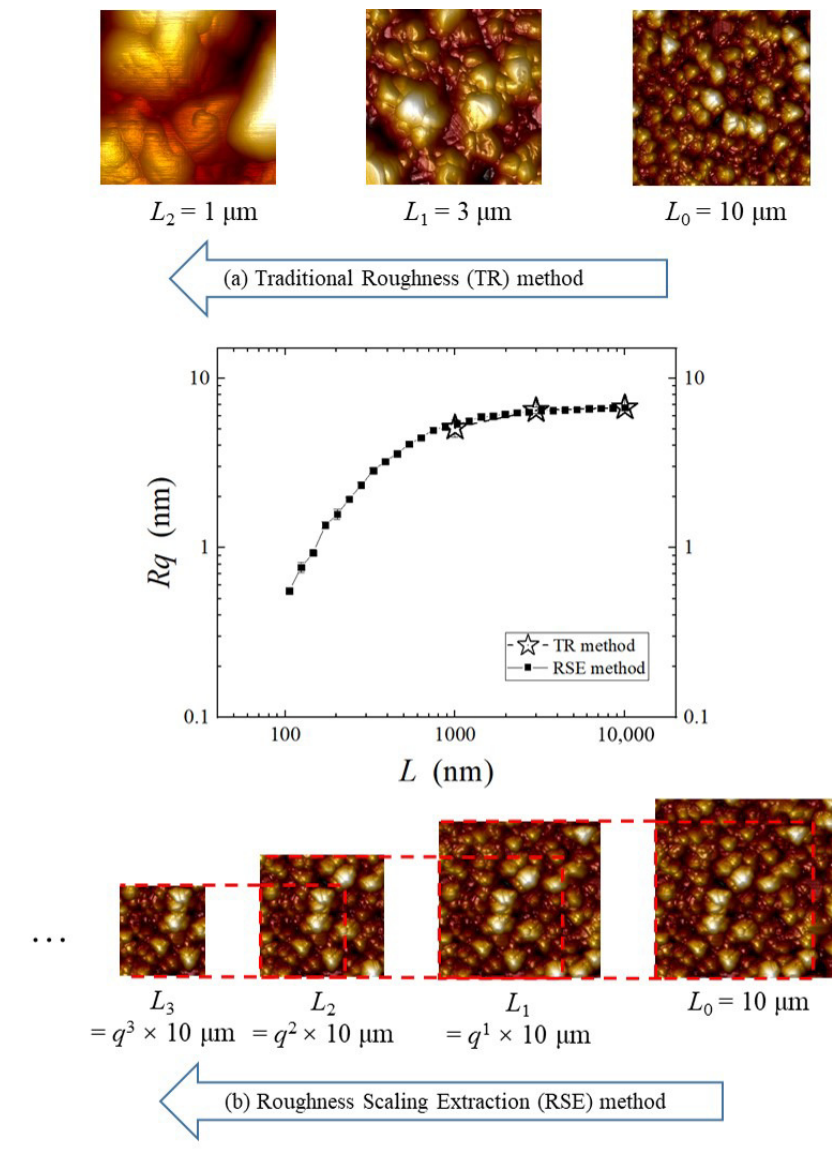
Figure 5. Comparison of the operation processes of ( a ) TR method, ( b ) RSE method ( q was the segmentation